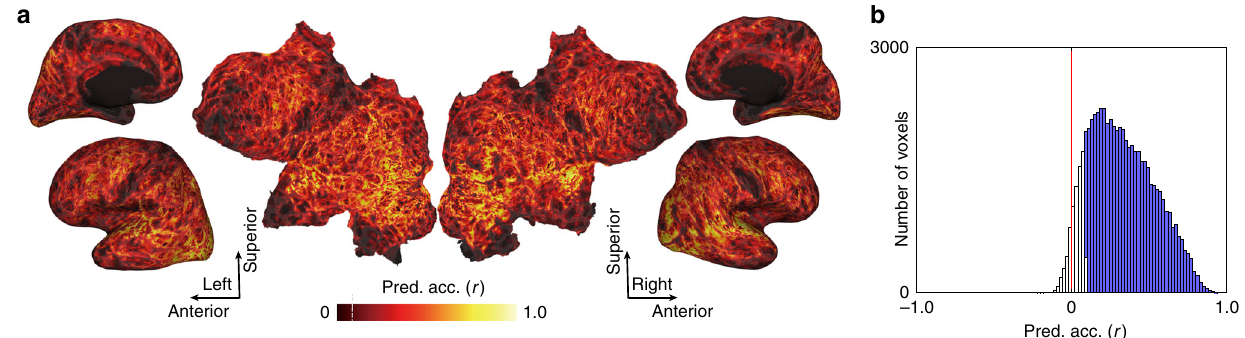
Fig. 5 Predicting the brain activity of novel tasks using the cognitive factor model. a Cortical map of model prediction accuracy on in fl ated and fl attened cortical sheets of subject ID01 (Supplementary Fig. 6 shows other subjects). The mean prediction accuracy across the cortex was 0.323 (87.2% of voxels were signi fi cant; p < 0.05, FDR-corrected; dashed line indicates the threshold). The minimum correlation coef fi cient for the signi fi cance criterion was 0.0846. b Histogram of prediction accuracies for all cortical voxels for subject ID01 (Supplementary Fig. 7 shows other subjects). Filled bars indicate voxels that were predicted with signi fi cant accuracy.